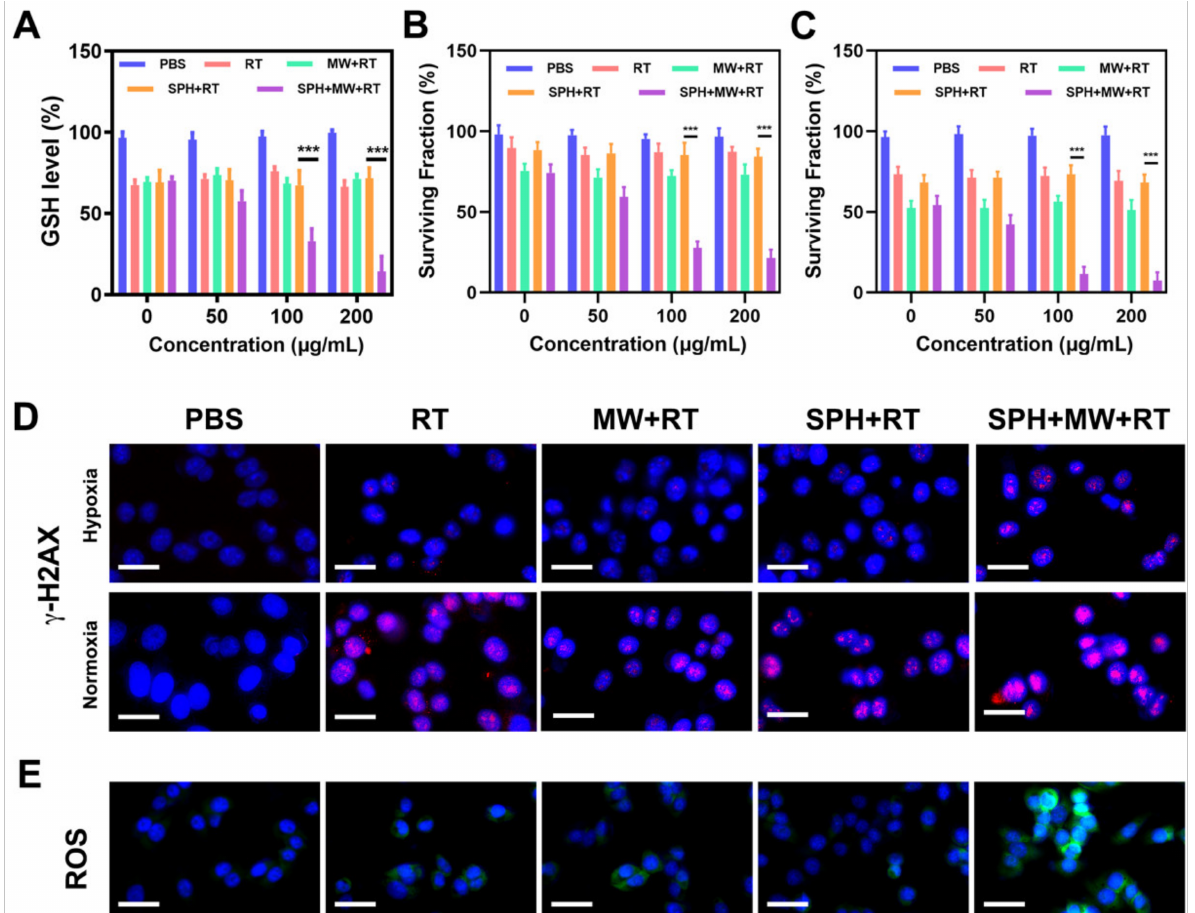
Figure 3. ( A ) The effect of different formulations on intracellular GSH levels (n = 3). ( B ) Colony formation assay results for 4T1 cells after different treatments under hypoxic conditions (n = 3). ( C ) Colony formation assay results for 4T1 cells after different treatments under normoxic conditions (n = 3). ( D ) γ -H 2 AX-stained 4T1 cells after different treatments under hypoxic or normoxic conditions. ( E ) Fluorescence images of ROS production in 4T1 cells following various treatments. (n = 3). Scale bars: 50 µ m. * p < 0.05, ** p < 0.01, *** p < 0.005; Student’s t